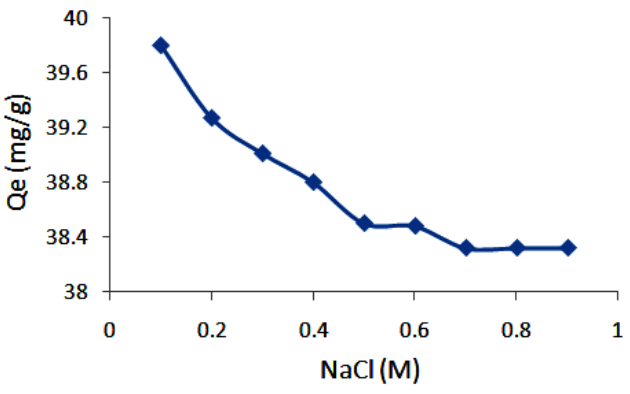
Figure 5. Effect of ionic strength on adsorption of MR dye at D. viscosa plant bark powder.